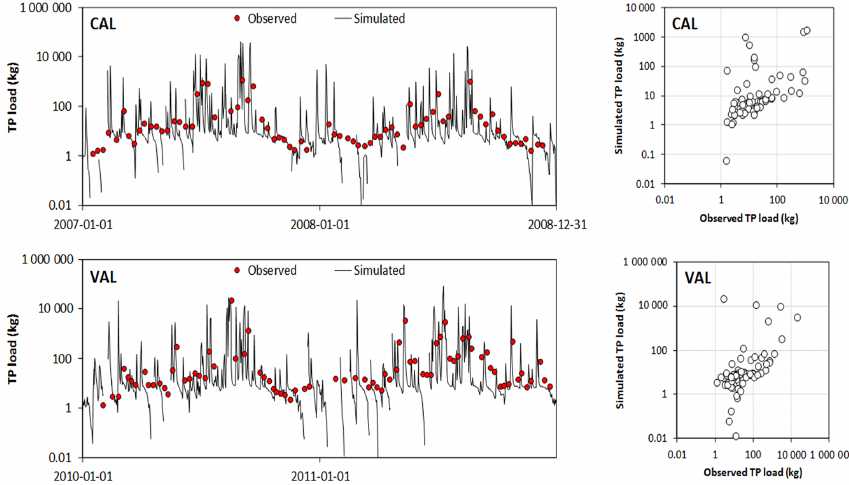
Figure 7. Comparison of simulated and observed total phosphorus (TP) load for calibration (top) and validation (bottom) periods.